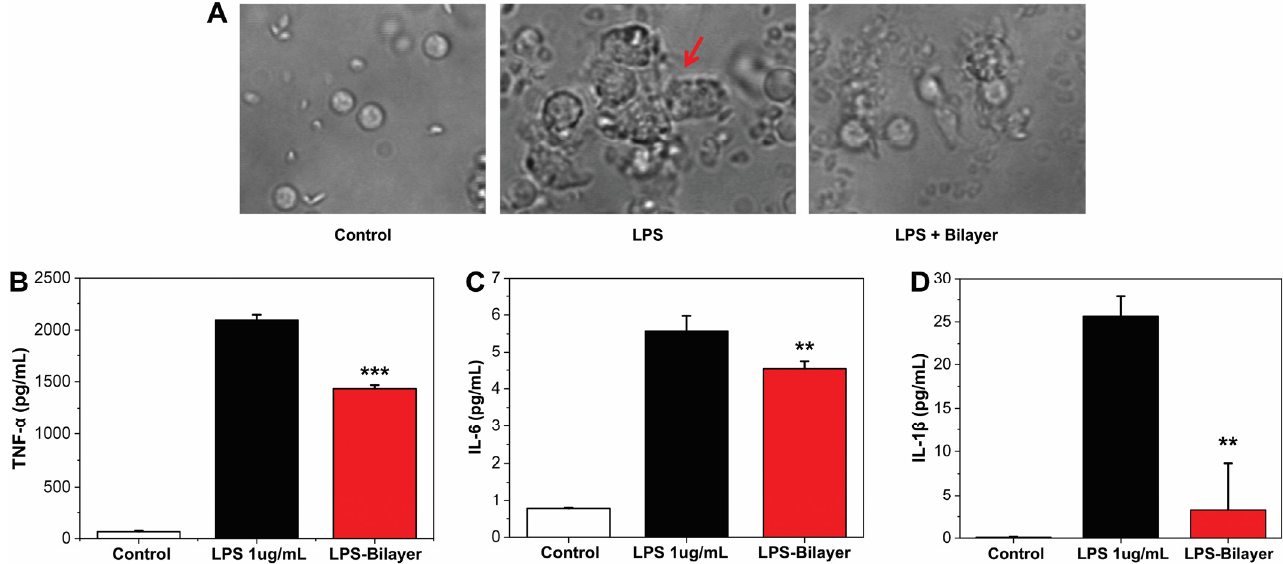
Figure 2. ( A ) Optical images of control samples of PBMC cells; PBMCs and LPS; and PBMC, LPS, and bilayer, respectively. The red arrow indicates the clusters caused by the LPS presence. ( B – D ) Histogram of the level of TNF- α , IL-6, and IL-1 β quantified by ELISA and expressed in the control samples of PBMC cells; PBMCs and LPS; and PBMC, LPS, and bilayer. ** p < 0.01 vs. the LPS treated group; *** p < 0.001 vs. the LPS treated group.